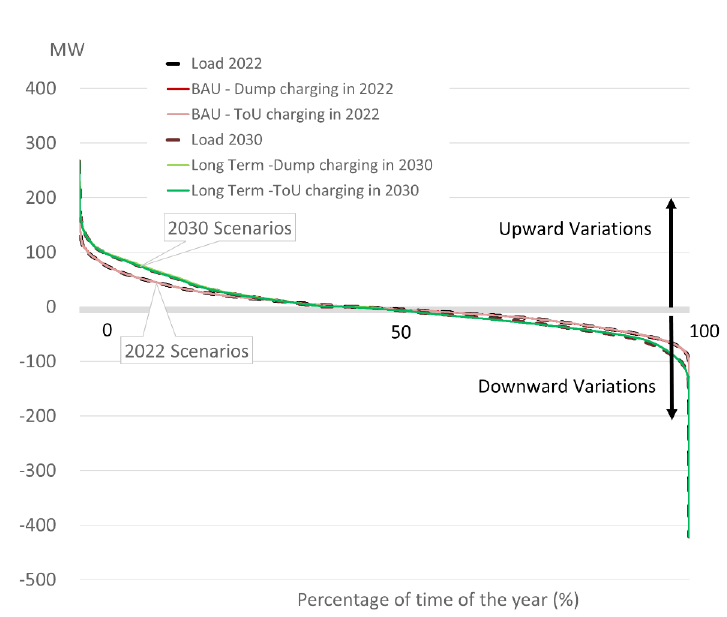
Figure 7: Duration curves of the variability.